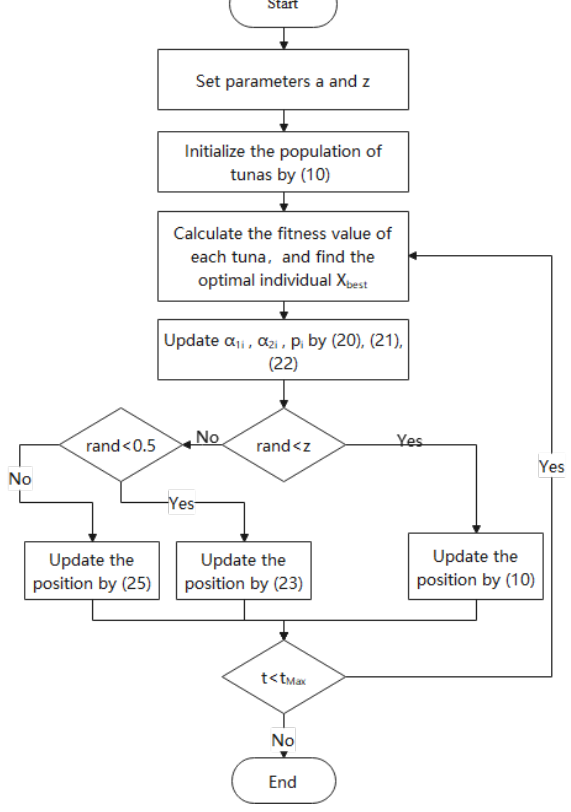
Figure 6. Flow chart of CLTSO. Algorithm 2 Pseudocode of CLTSO Algorithm